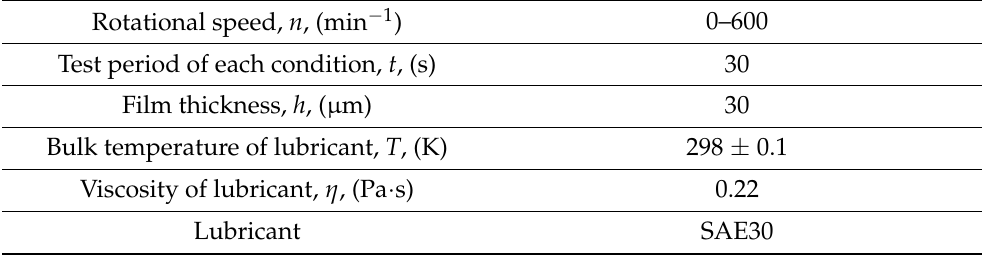
Figure 6. An example of measurement results, n = 400 min − 1 , h = 30 µ m: ( a ) load-carrying capacity; ( b ) frictional torque. Table 1. Experimental conditions.